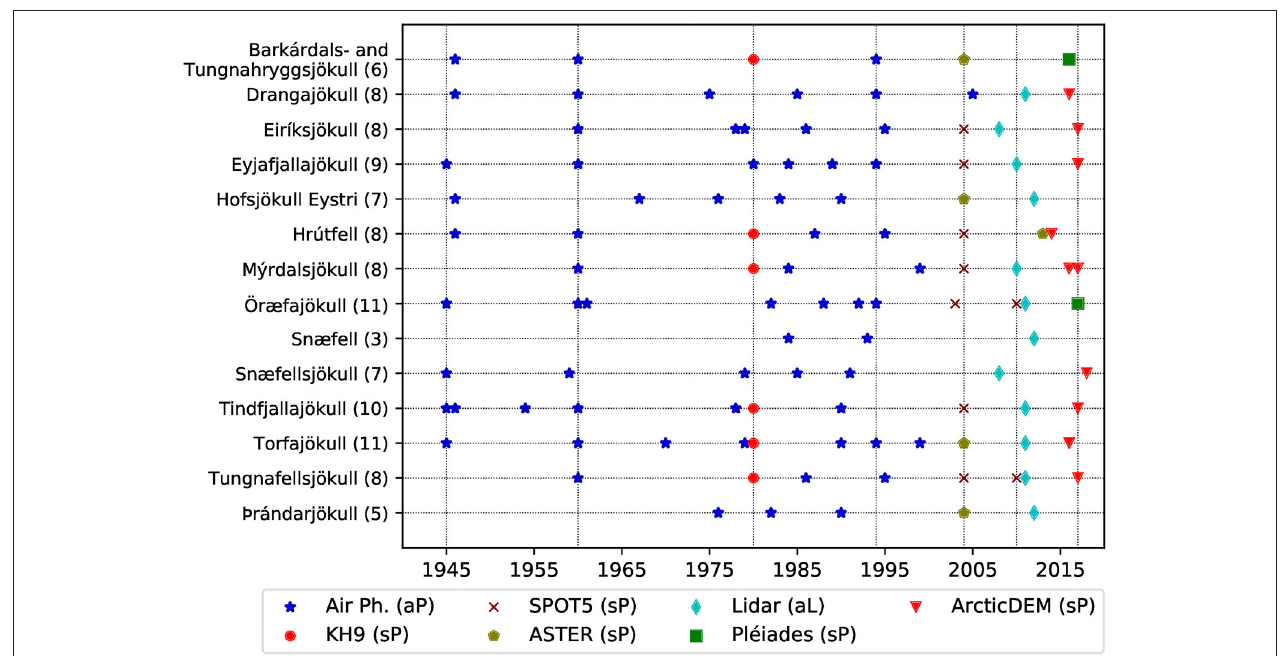
FIGURE 2 | Temporal distribution of the datasets for each glacier. The numbers in parentheses indicate the amount of surveys carried out on each glacier. Vertical lines are emplaced at the most repeated survey times, based on airborne photogrammetry (aP, 1945, 1960, 1994) and spaceborne photogrammetry (sP, 1980). 2004 contained abundant measurements from SPOT 5 ( Korona et al., 2009) and ASTER (Raup et al., 2007). The airborne lidar (aL) surveys are spread over five years and adjusted to year 2010 (Jóhannesson et al., 2013). Recent satellite sub-meter stereo images from Pléiades (Berthier et al., 2014) and the ArcticDEMs (Porter et al., 2018) were acquired during 2016–2018 and adjusted to